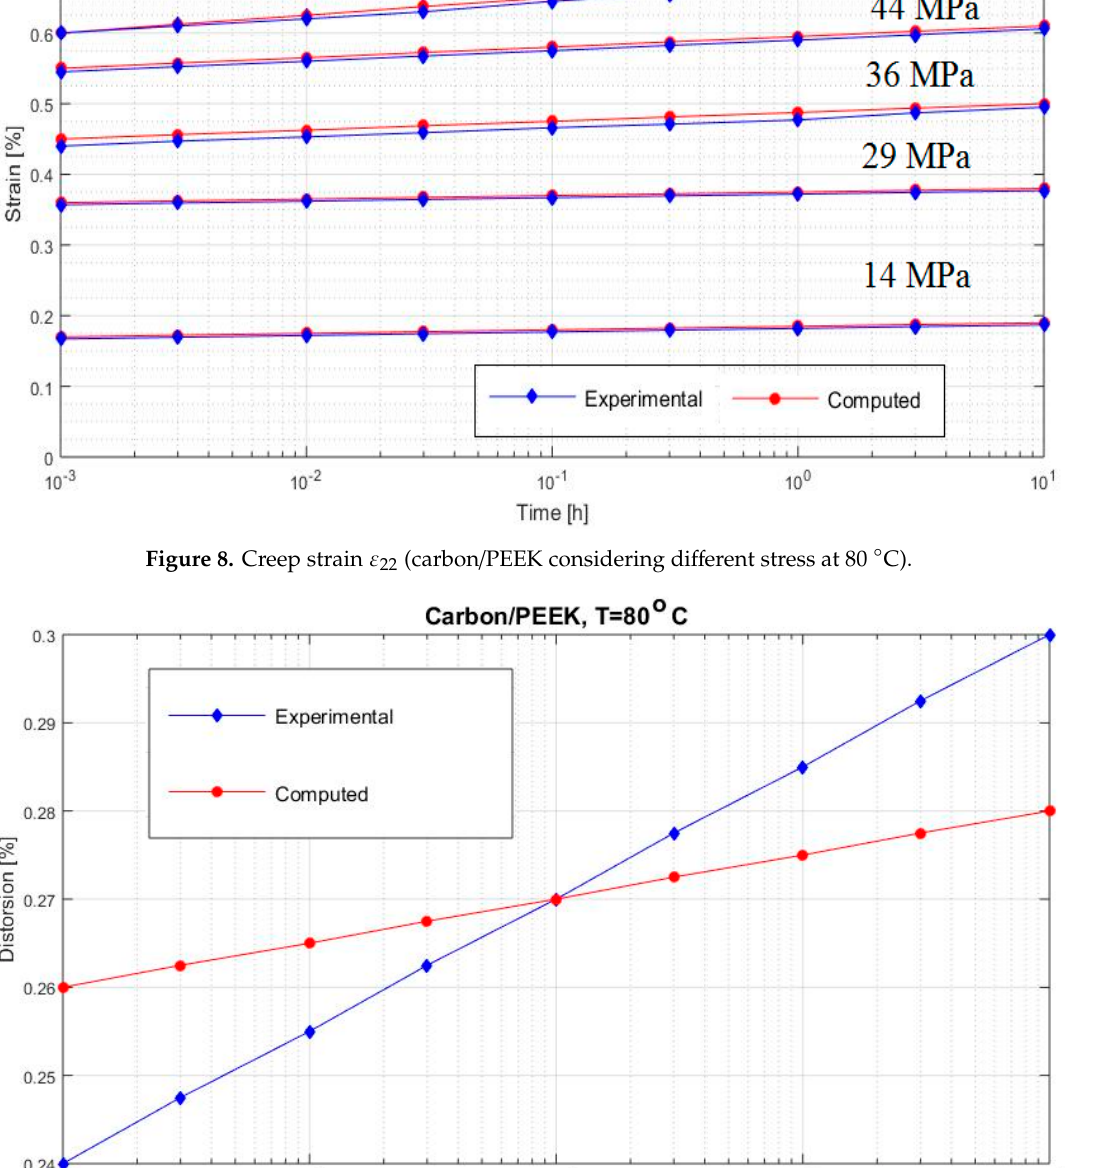
= τ 13 MPa at 80 °C). 12